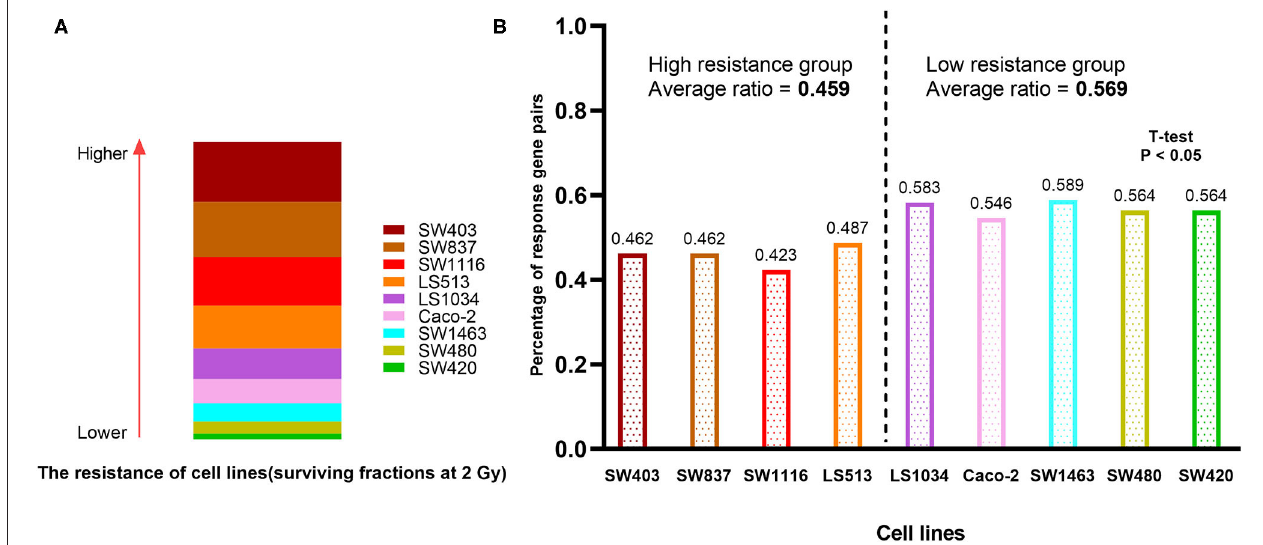
FIGURE 6 | Cell line verification. (A) The resistance of nine colorectal cancer cell lines to chemoradiation. The rectangular area represents the resistance of the cell line to chemoradiation. (B) The percentage of response gene pairs in resistant and sensitive group.